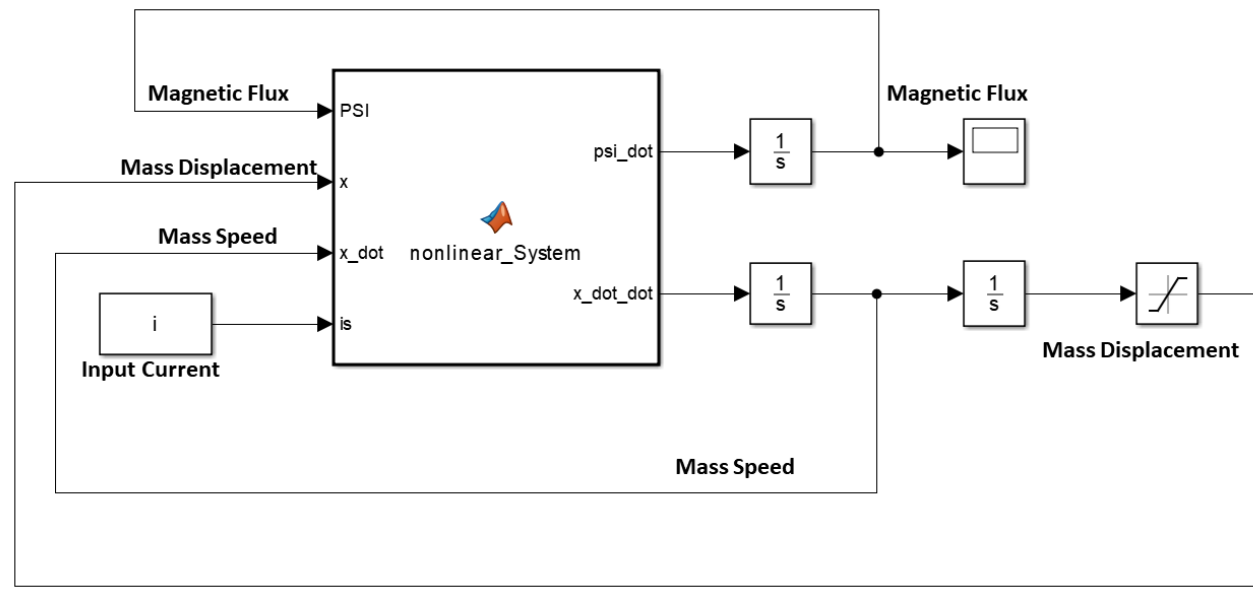
Figure 5. Simulink implementation of the electromechanical oscillator.